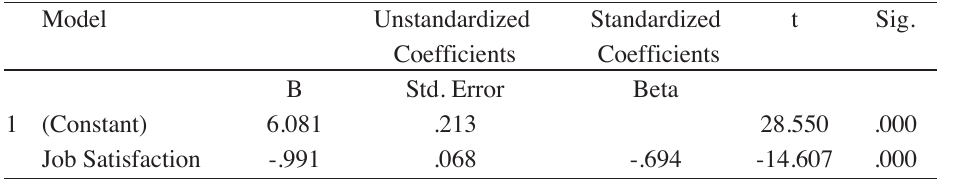
Coefficients of Job Satisfaction and Intention To Leave Model Unstandardized Standardized t Sig.